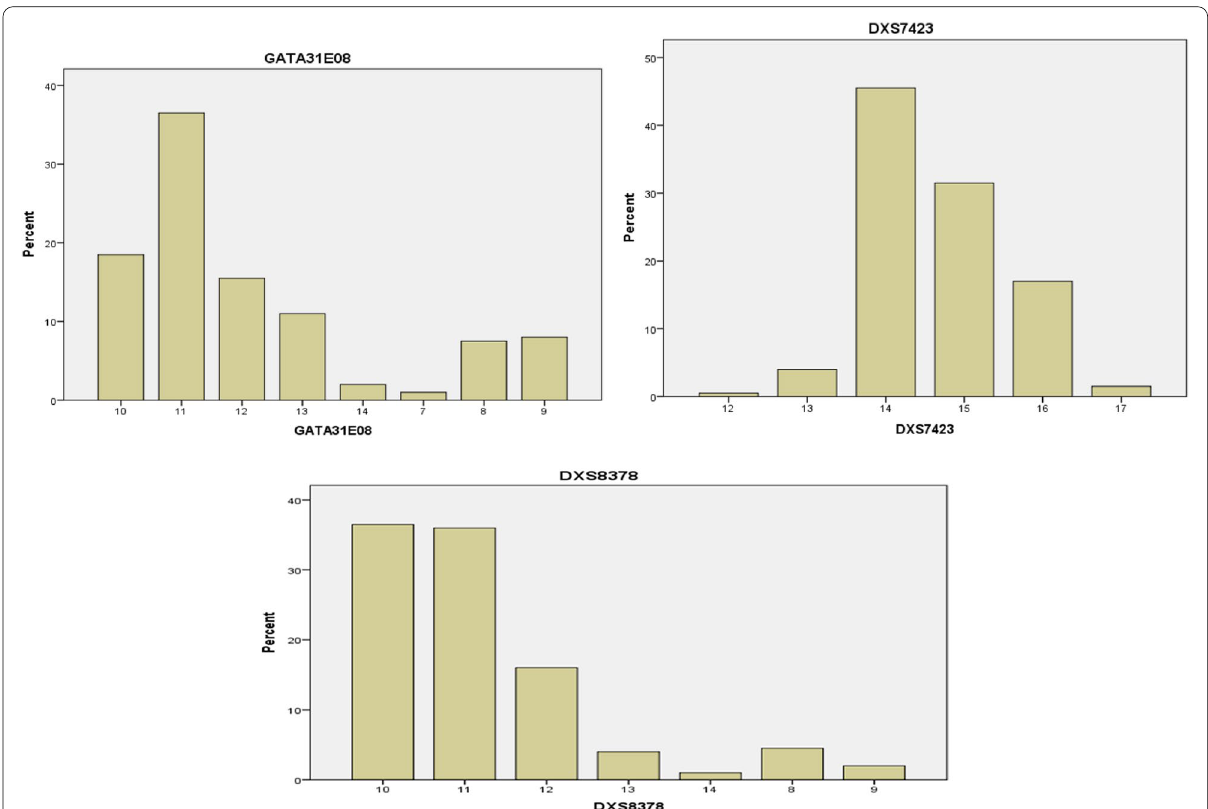
Fig. 3 The percent distribution of allele frequency of second group (GATA31E08, DXS7423, and of DXS8378)